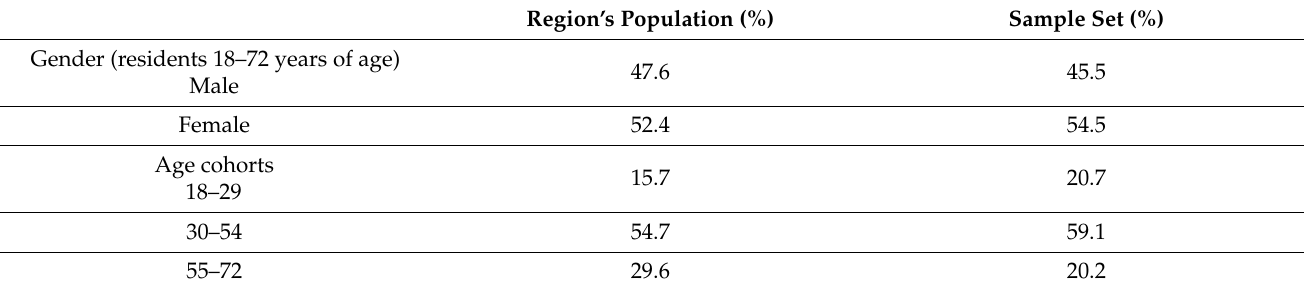
Table 1. The ratio of sample parameters and characteristics of the population of the studied territories. Region’s Population